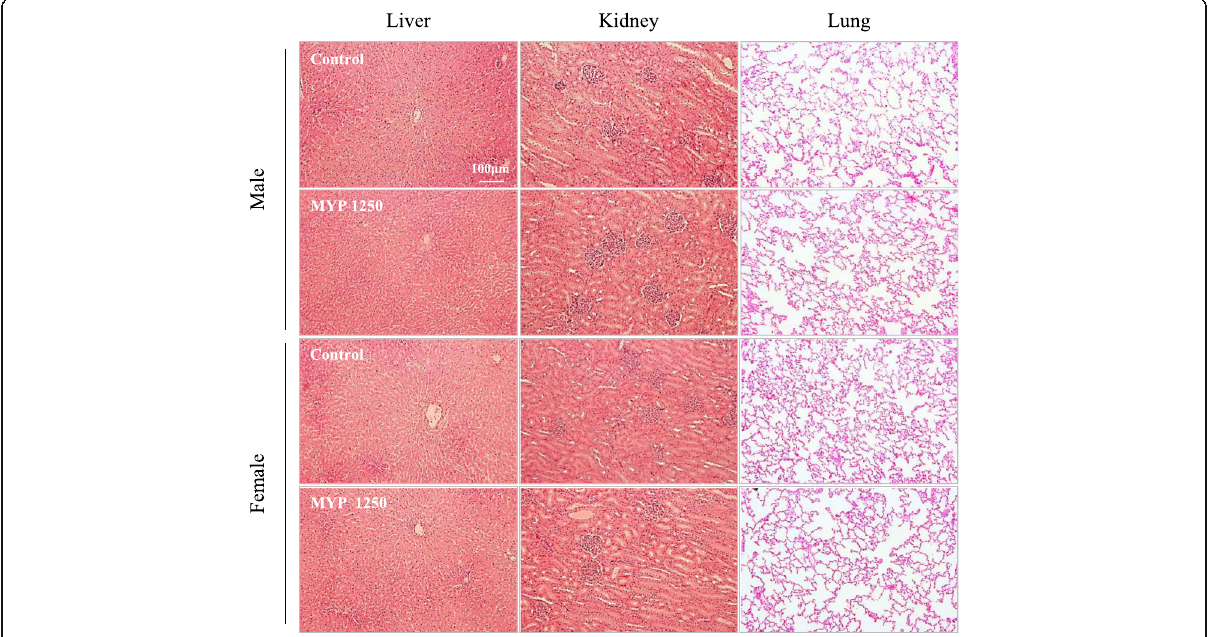
Fig. 3 Histopathological findings. Representative pictures from H&E staining sections of the liver, lung, and kidney. No significant abnormalities associated with drug was